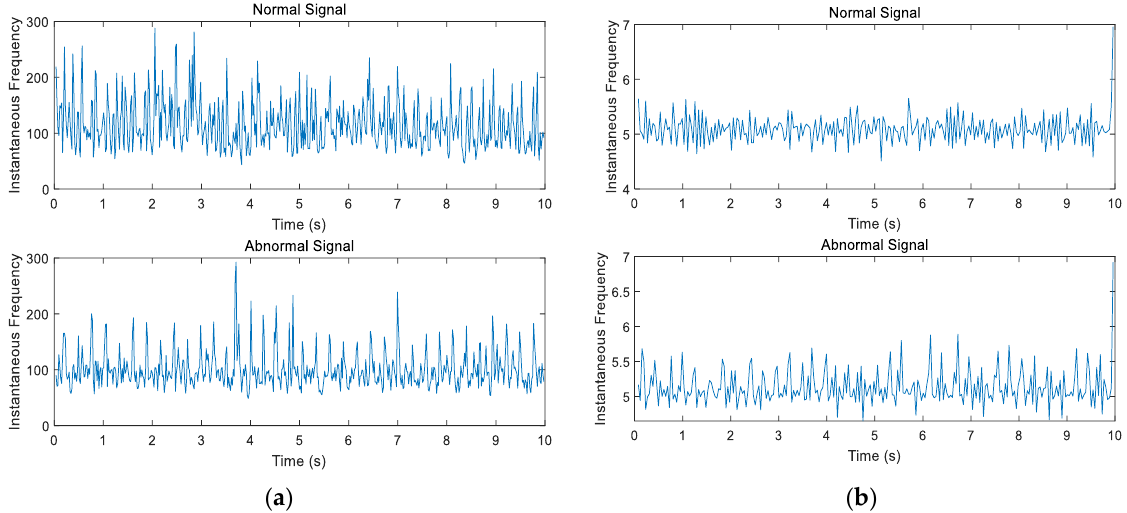
Figure 8. Comparison before and after filtering: ( a ) ECG original signal; ( b ) ECG signal after filtering.